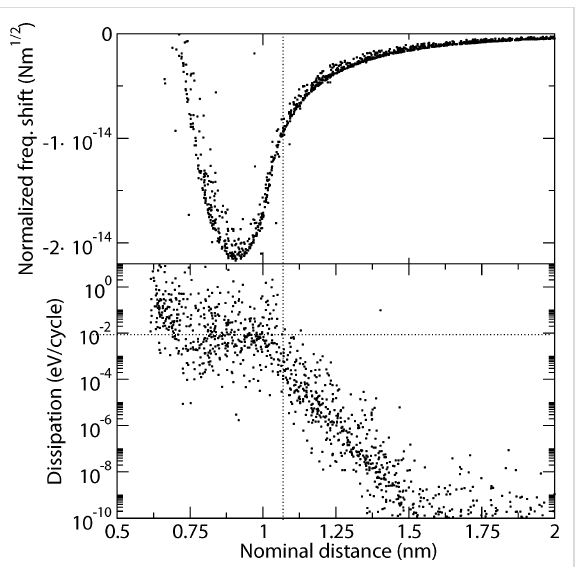
Figure 8: Topography and dissipation for Monte-Carlo parameter- space